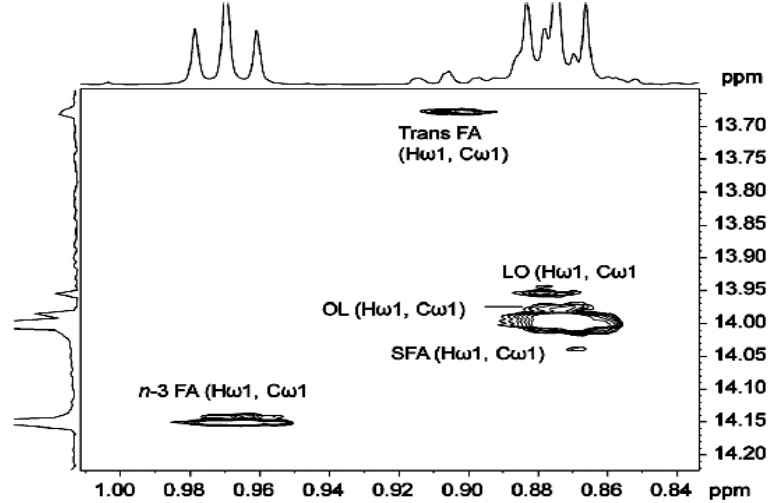
Figure 18. 850 MHz band selective 1 H- 13 C gHSQC spectrum of the aliphatic region of a fish oil supplement. Adopted, with permission, from [60]. Copyright 2015, Royal Society of